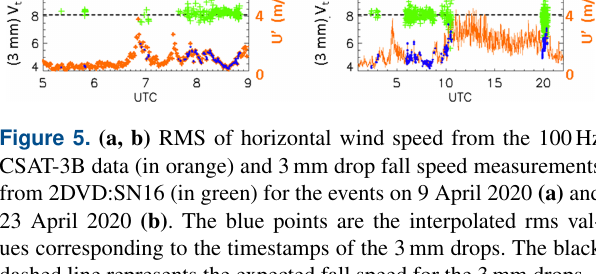
dard deviation ( σ f ) versus u (cid:48) . The relative deviation ( (cid:49)/V t ) increases approximately linearly with u (cid:48) /V t with a maximum “slowing” down of 10 % for the 3 mm and 6.25 % for the 2 mm for the dataset we have analysed. On the other hand, the σ f versus (un-normalized) u (cid:48) for both drop sizes are closer to each other (compared to < V f > in Fig. 7a) and increase nearly linearly for u (cid:48) < 2 m s − 1 . The latter two points are consistent with Fornari et al. (2016) who used direct